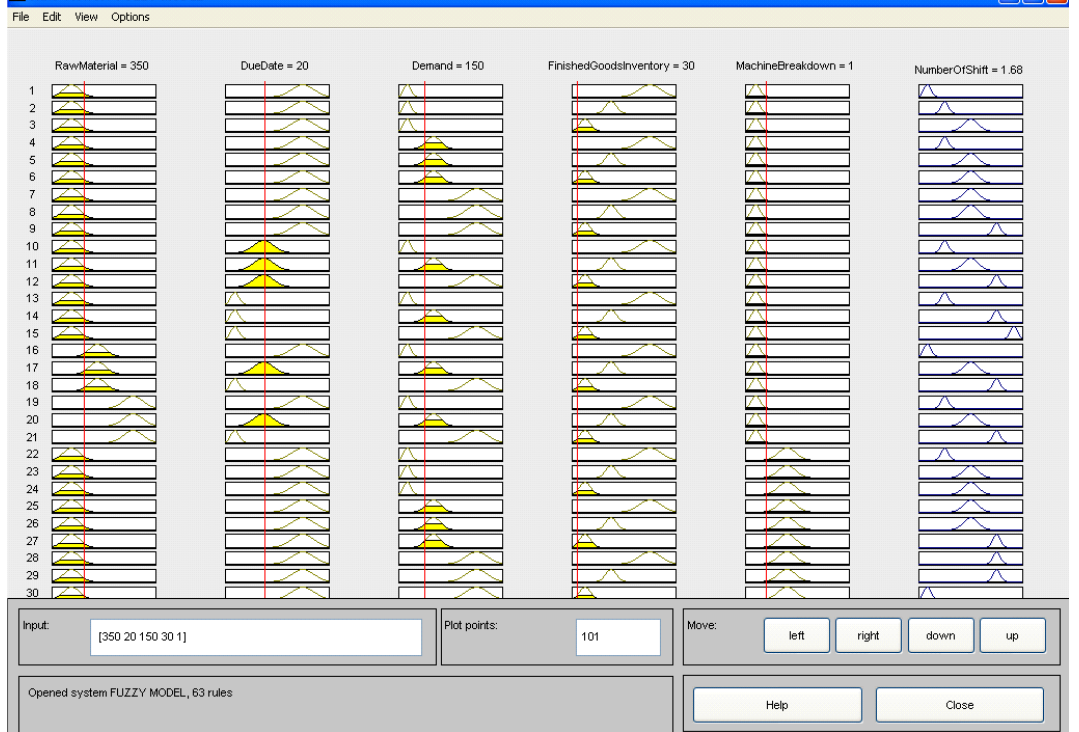
Figure 5. “View of Matlab Fuzzy Toolbox: Rule Viewer for company A”. Source: Own